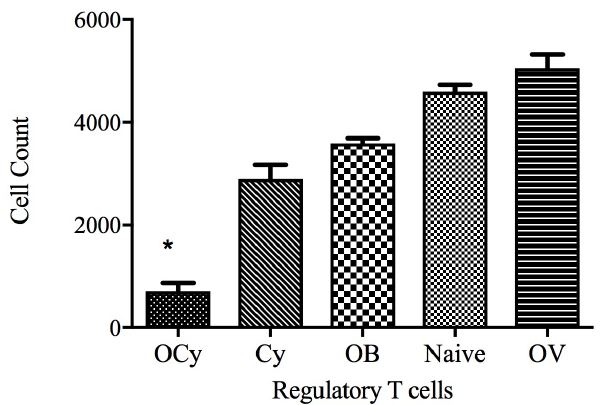
Figure 8. Analysis of the effect of cyclophosphamide (50 mg/kg) on the CD4 + CD25 + Foxp3 + regulatory T cell population. Cyclophosphamide was administered three days before the booster vaccine doses. Spleens ( n = 6) were collected, and regulatory T cell populations were analyzed by flow cytometry * p < 0.001 (OCy: orally administered vaccine microparticles + cyclophosphamide; OV: orally administered vaccine microparticles; OB: orally administered blank microparticles; Cy: cyclophosphamide).